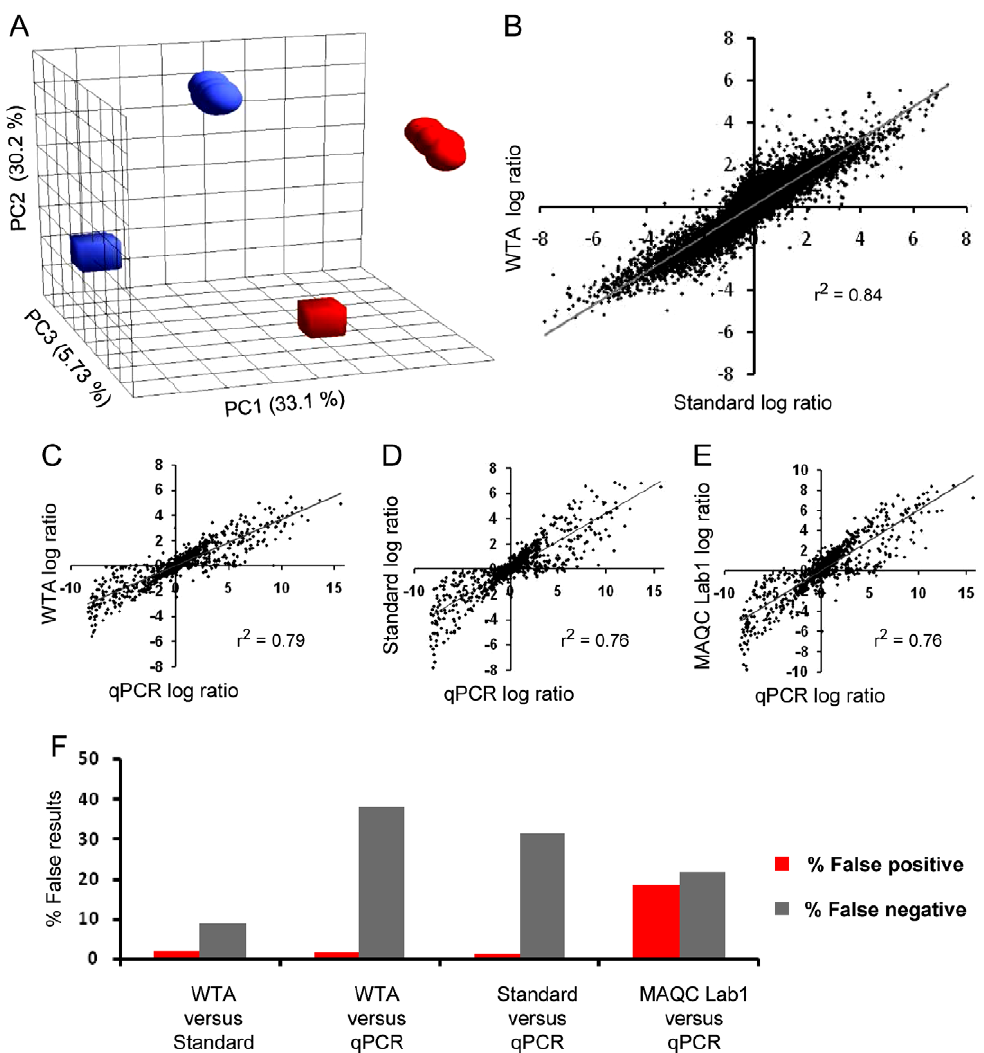
Figure 2. Evaluation of WTA for expression profiling. A , PCA of expression profiles of MAQC samples A (red) and B (blue) processed in triplicate following the manufacturer’s recommendations (cubes) and processed seven times on different days using WTA (globes); the contribution of the specific component is shown next to its axis. B , correlation of differential expression between MAQC samples A and B measured by the manufacturer’s method and using WTA; average values of triplicates are displayed and all measurements of all probe sets are displayed. C to E , correlation of differential expression measured by ( C ) qPCR versus WTA, ( D ) qPCR versus the standard method and ( E ) qPCR versus laboratory 1 of the original MAQC study. F , Quantification of false positive and false negative rates for several expression profiling methods; from left to right: for WTA versus the manufacturer’s protocol, for WTA versus qPCR, for the manufacturer’s protocol versus qPCR, and for microarray measurements from the original MAQC study versus qPCR. (Figure 3C). Differential expression from Pico Profiling correlated only slightly lower with qPCR (Figure 3D) than differential expression from WTA-based expression profiles from nanograms RNA (Figure 2C). The reduced correlation affected high-copy- number transcripts to a lesser extent than it affected low-copy number transcripts (Figure S3).